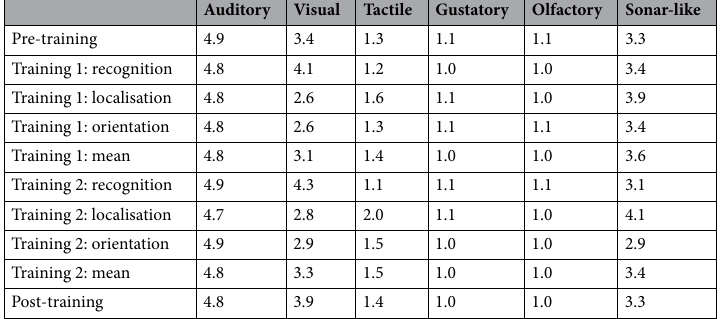
Table 1. Phenomenologies associated with The vOICe’s use as a function of the task and session, averaged across participants in the experimental group. Pre-training and post-training refers to questionnaires administered each time just after the interference task. Note that, as the sonar-like experience often reappeared in participants’ verbal reports 10 we added this scale in the